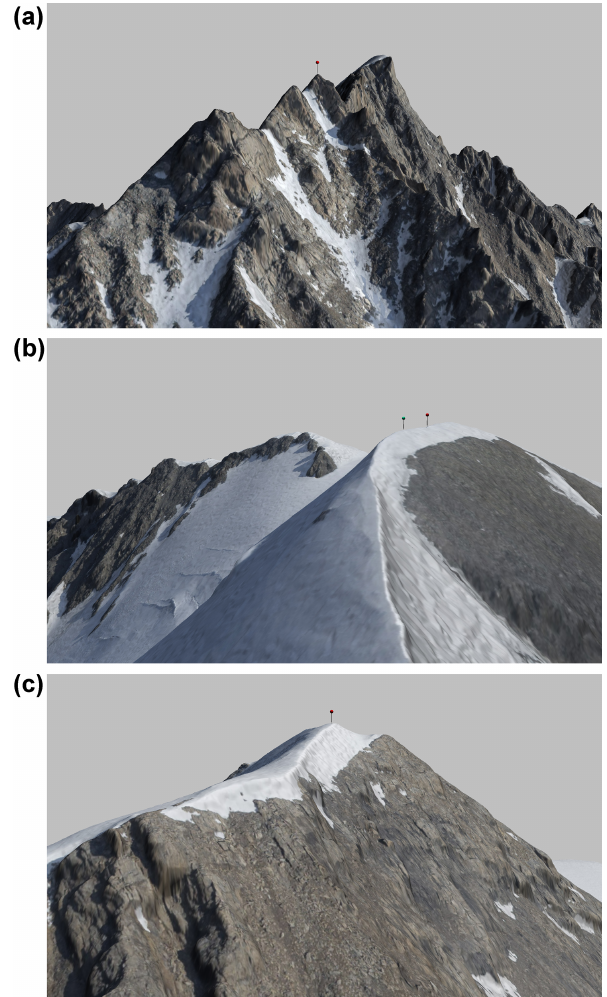
Figure 7. The peak of Mt. Hubley (a) is on a rock arête along a ridge that is too steep and narrow to support large glaciers. Mt. Michel- son (b) and Mt. Okpilak (c) are only a few meters apart in height and both are covered by cornices several meters thick. As climate con- tinues to warm, the ranking of these two may yet change. The loca- tion of Mt. Okpilak’s “peak” moved more than 15m between 2014 and 2015, as it lies on a nearly flat ridge, but its elevation changed by less than